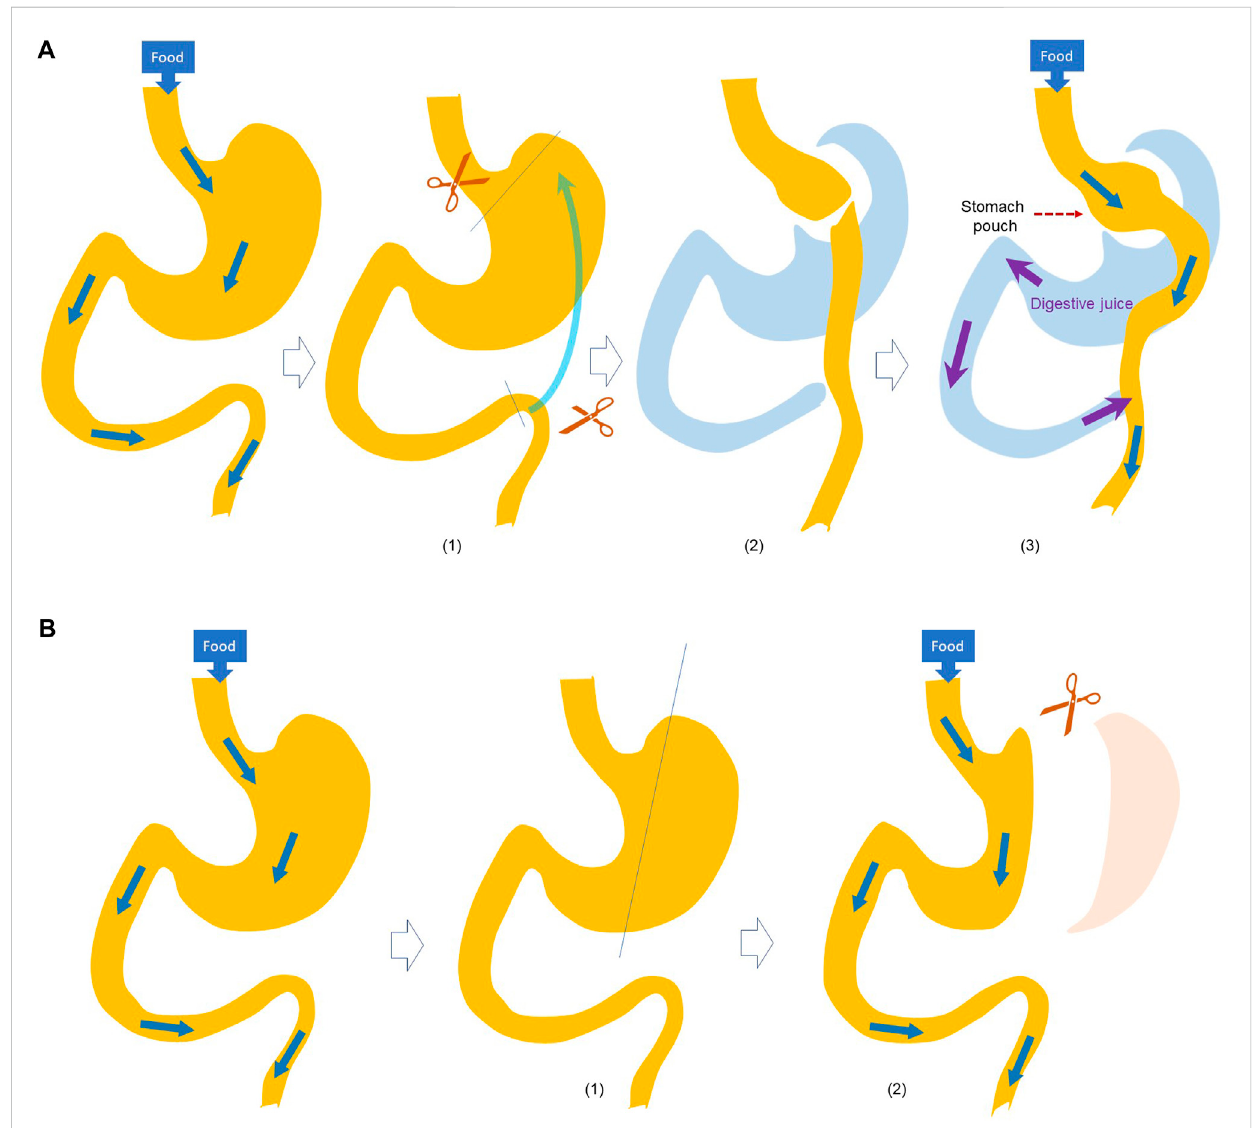
FIGURE 1 Schematic illustration of (A) Roux-en-Y Gastric Bypass (RYGB) and (B) SGx surgery. RYGB (asmbs, 2019): A small stomach pouch is made (CDC, 2022); The small intestine is divided and brought up (Wiggins et al., 2020); the small intestine is connected to the small stomach pouch, and the stomach end of divided intestine is connected to the small intestine to allow digestive juice mixing with the food. SGx (asmbs, 2019): A catheter is passed thought the mouth into the duodenum, and (CDC, 2022) a stomach is divided to crate a narrow gastric